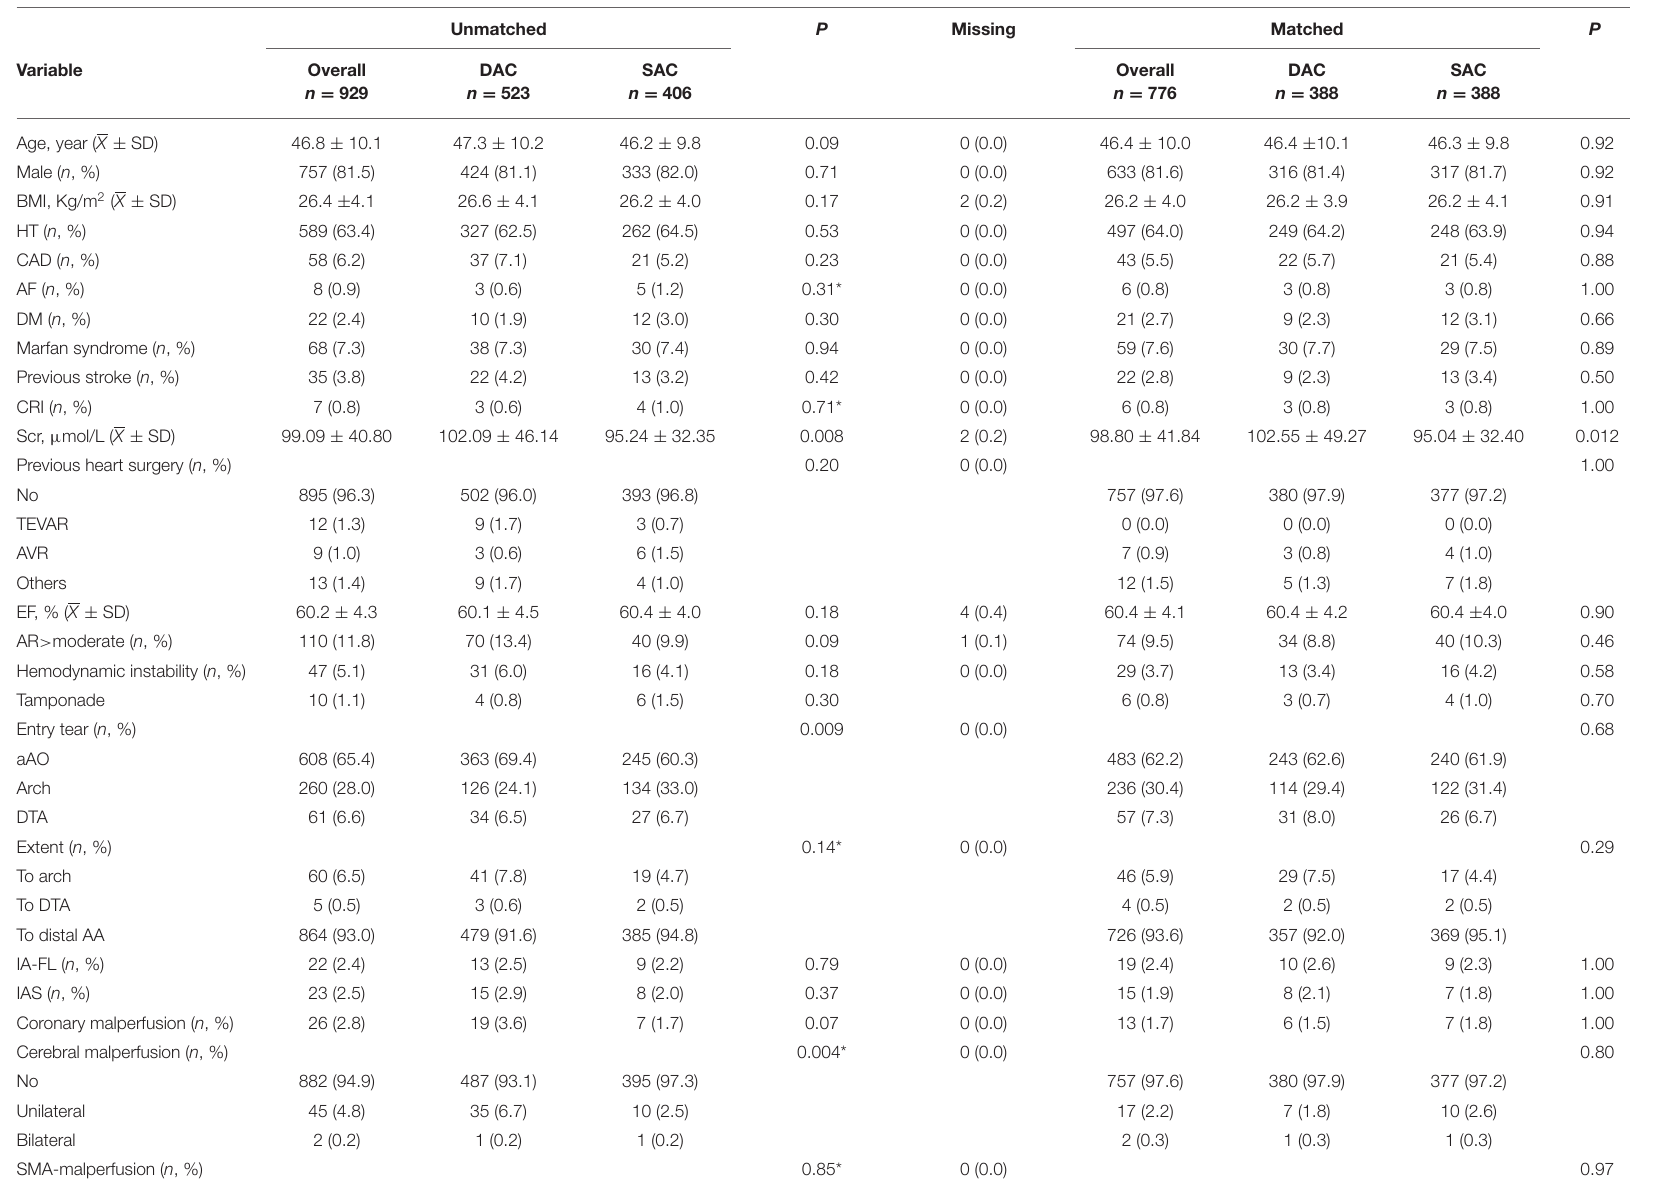
TABLE 1 | Baseline